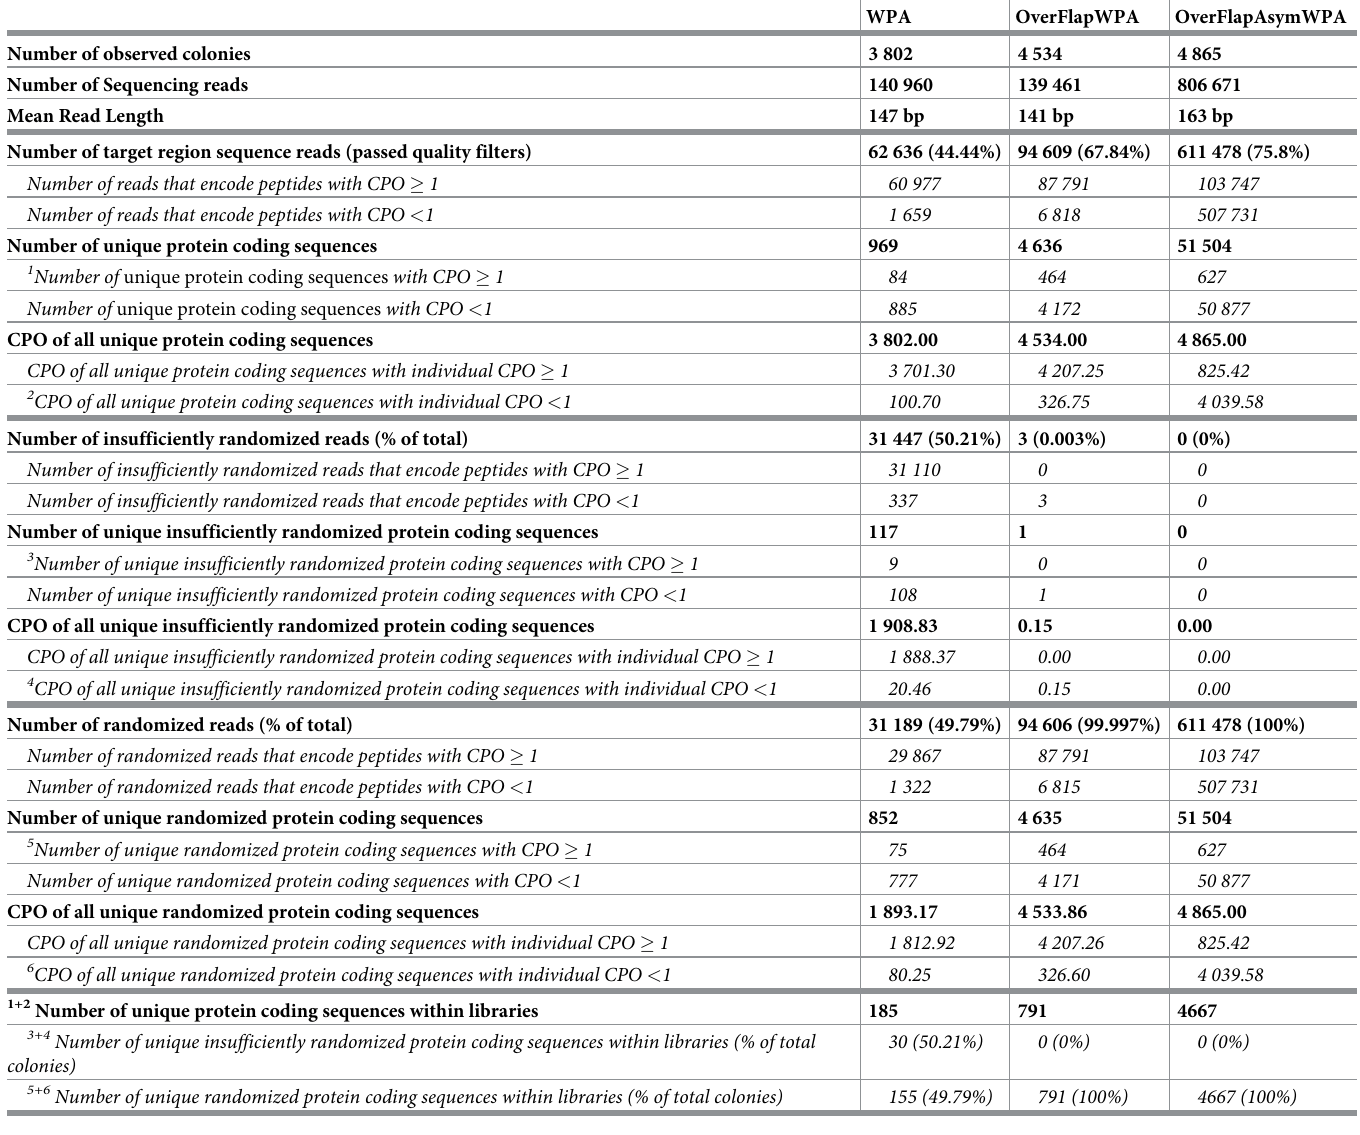
Table 2. General characteristics of the acquired sequencing data and an overview of the results of the subsequent data analysis. WPA represents randomization through whole circular plasmid amplification, OverFlapWPA represents OverFlapPCR based whole plasmid amplification, and OverFlapAsymWPA represents Over- FlapPCR based asymmetric whole plasmid